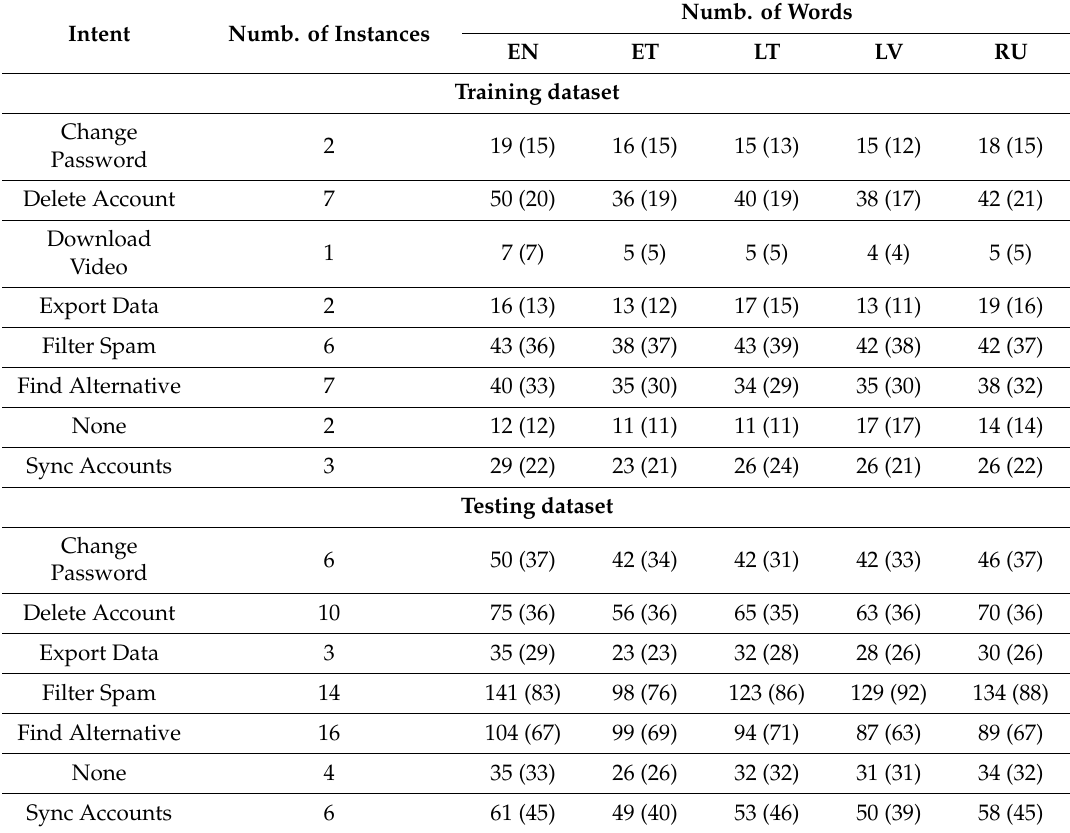
Table 3. Statistics about the webapps